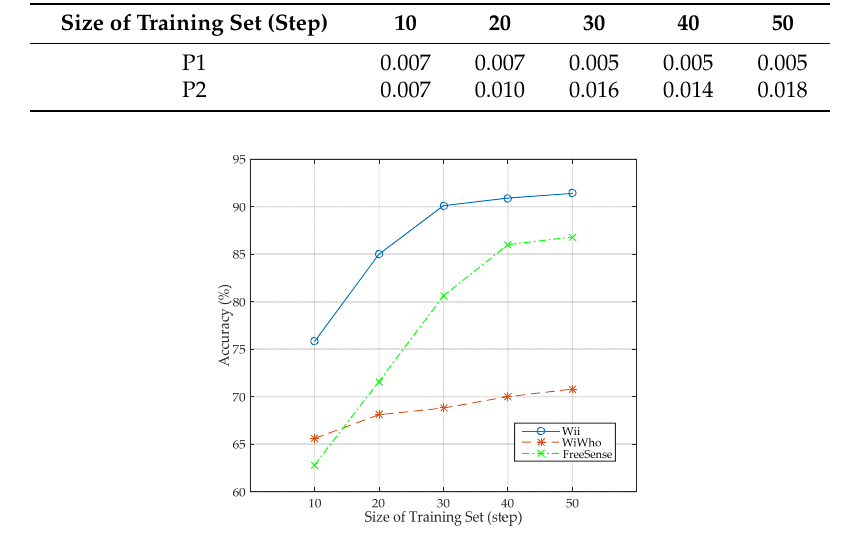
Figure 11. Impact of the size of training set. Figure 10. Impact of the size of training set.